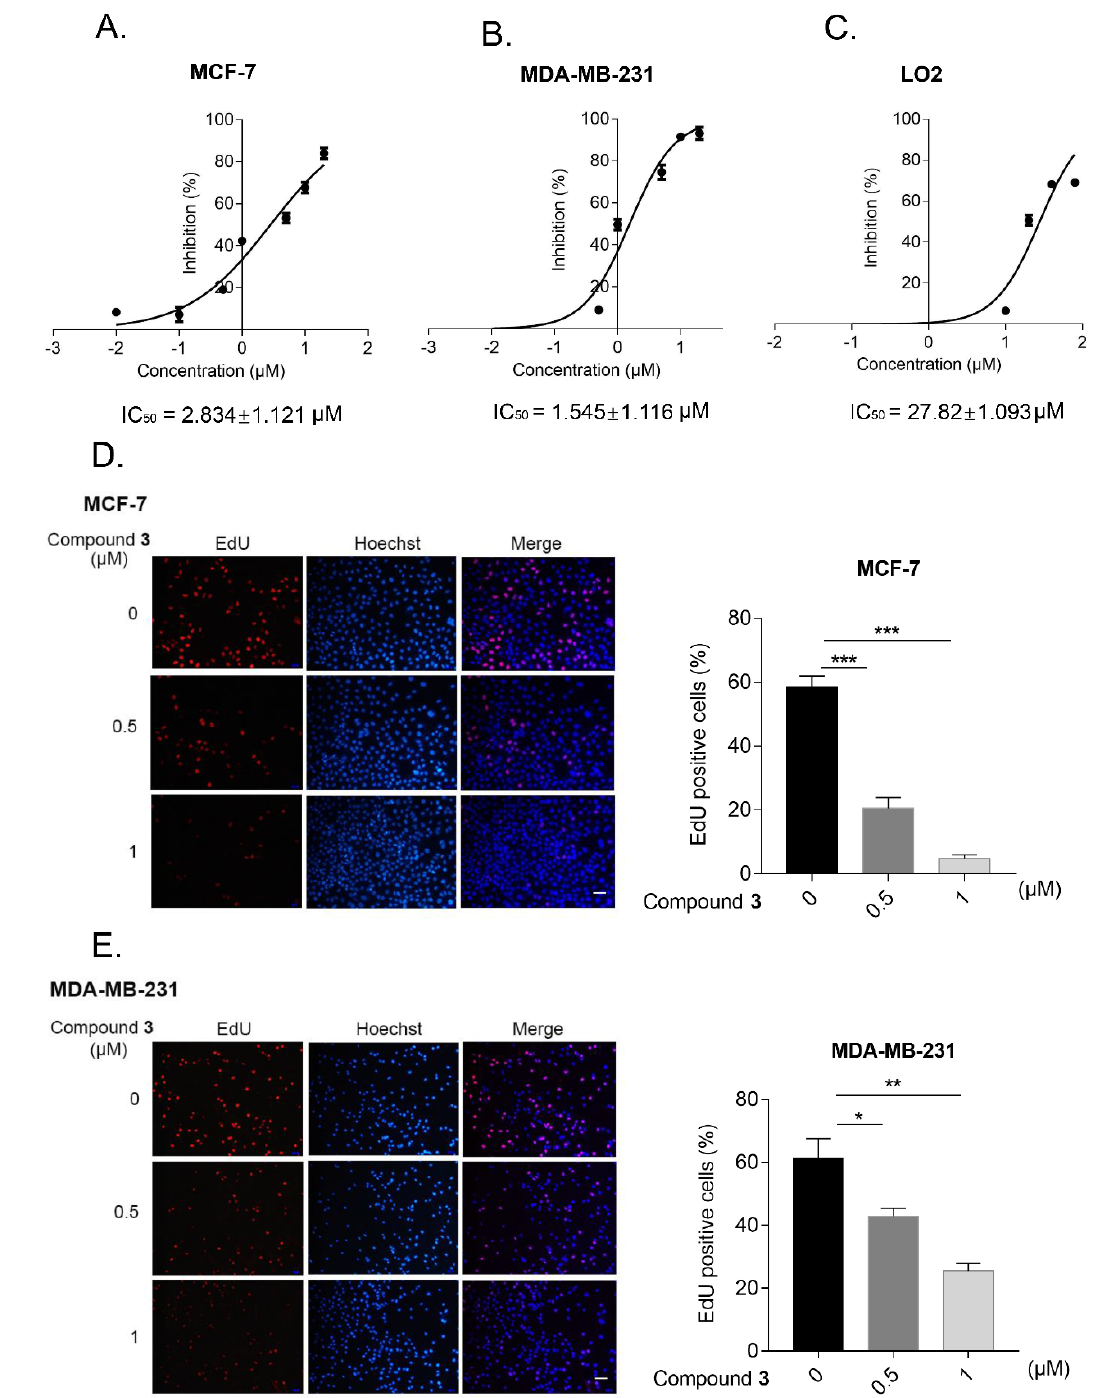
Figure 5. Compound 3 inhibited the proliferation and growth of human breast cancer cells. ( A – C